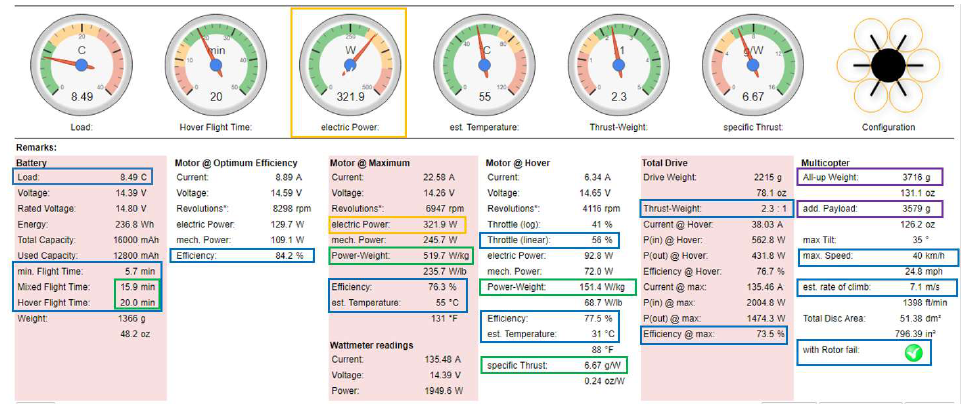
Figure 16. Results obtained after running the simulation using xcoperCalc platform.